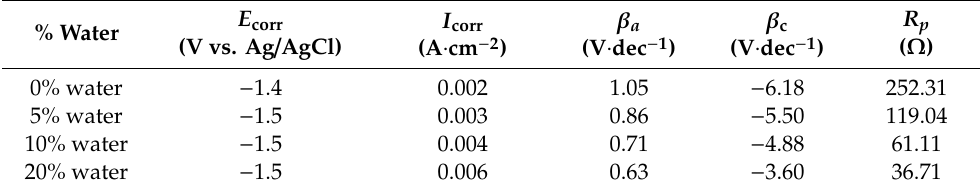
Table 1. Results of Tafel polarization of Al in 3 M KOH in methanol solutions containing di ff erent ratios of water (0%, 5%, 10%, and 20% (v /